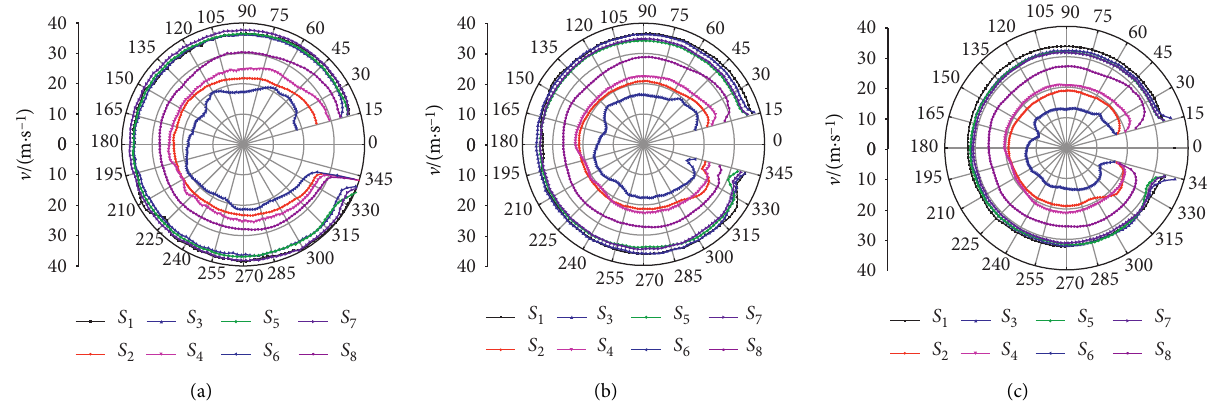
Figure 7: Velocity distribution of each curve at Z 1 characteristic section. (a) O 1 curve. (b) O 2 curve. (c) O 3 curve.